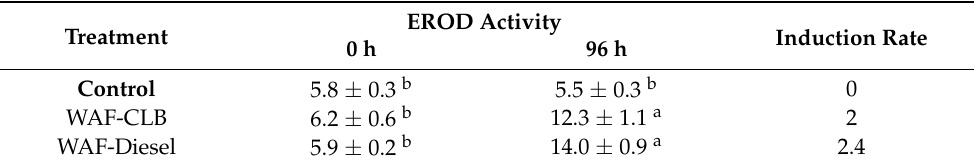
Table 2. EROD activity in lobster hemolymph and associated induction rates for each treatment (Control, WAF-CLB, and WAF-Diesel) before (0 h) and after 96 h of exposure. Series A and B are combined. Mean ± SE; n =